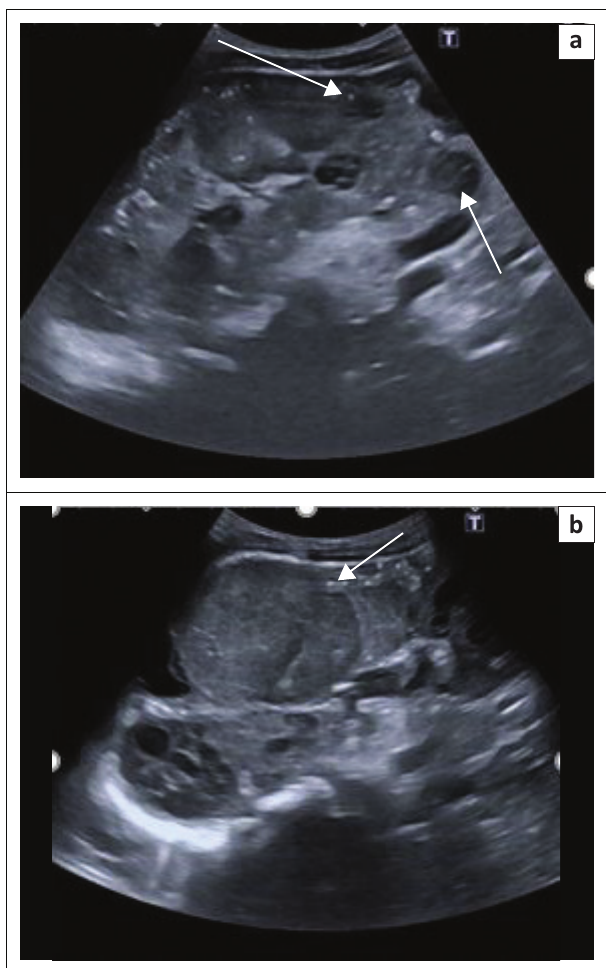
FIGURE 1: (a) Eleven-year-old male. Longitudinal greyscale ultrasound right kidney. Multiple markedly hypoechoic parenchymal masses were demonstrated (white arrows). (b) Longitudinal greyscale ultrasound left kidney. Large midpole mildly hypoechoic mass (white